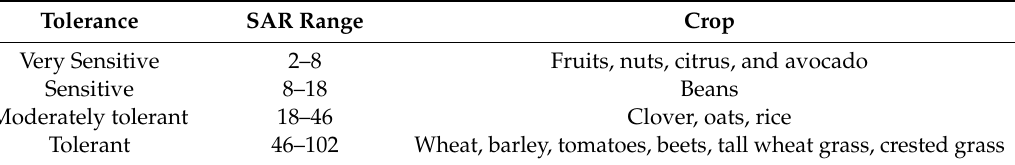
Table 2. Sensitivity of various crops to the SAR value.